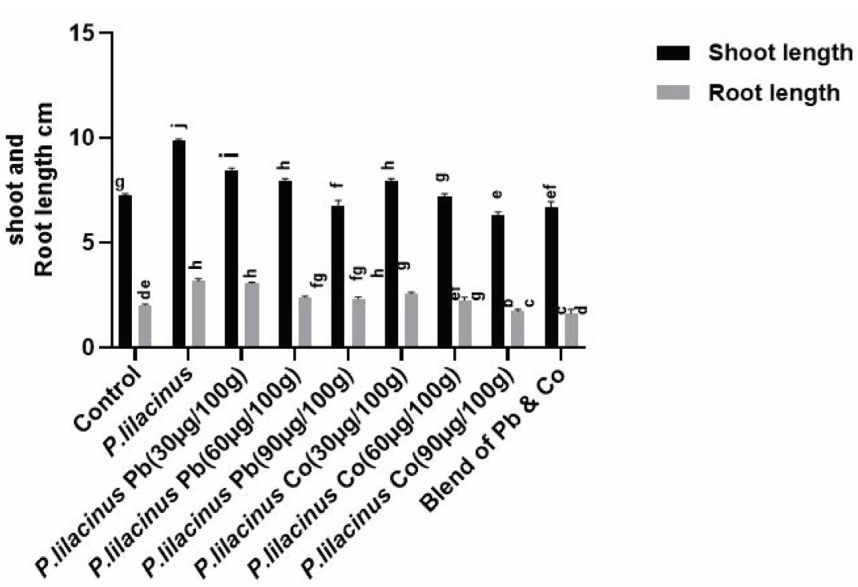
Figure 4. Effect of lead and cobalt stresses on S. lycopersicum inoculated with P. lilacinus and without P. lilacinus . Bars represent mean of triplicates with ± SE. Alphabets above the bars are significantly different from one another at p ≤